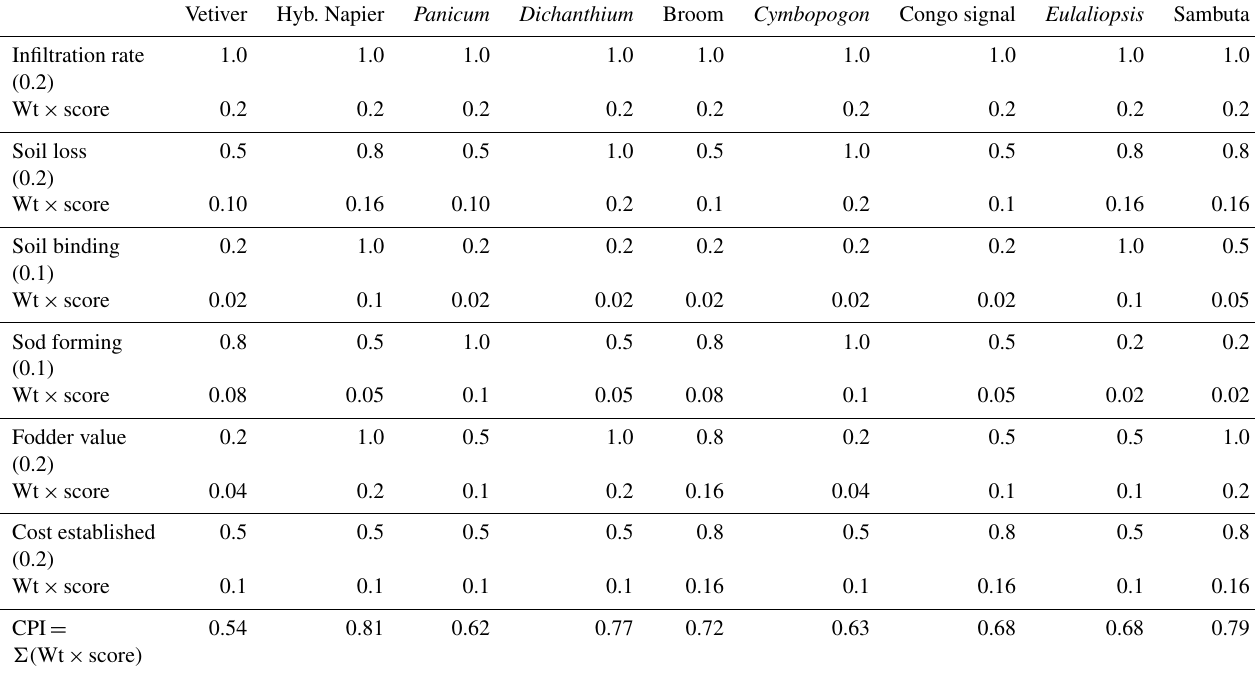
Table 6. Comparative comprehensive performance index of vegetative barrier. Vetiver Hyb.